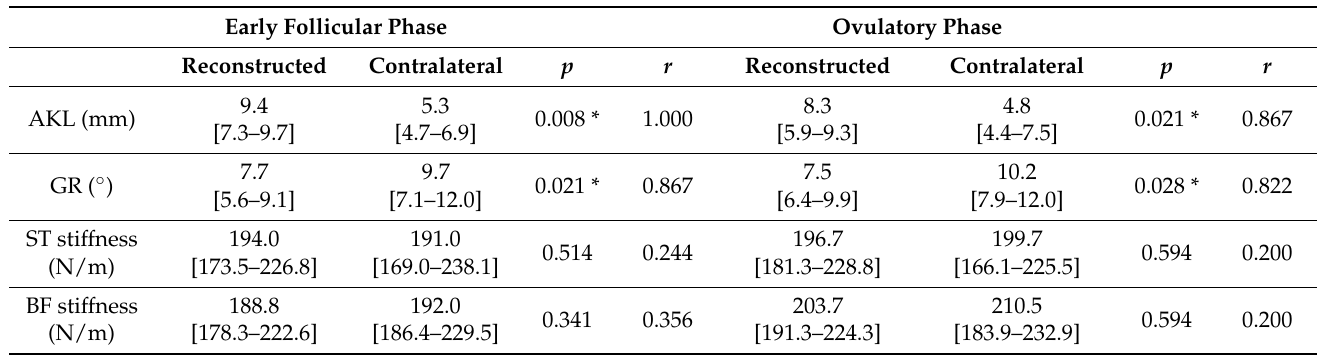
Table 4. Comparison of reconstructed and contralateral